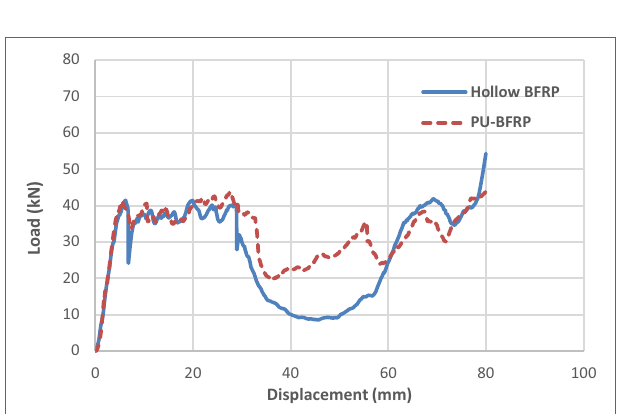
FigUre 8 | Axial crushing load vs. displacement of hollow and foam-filled flax FRP (FFRP) tubes.